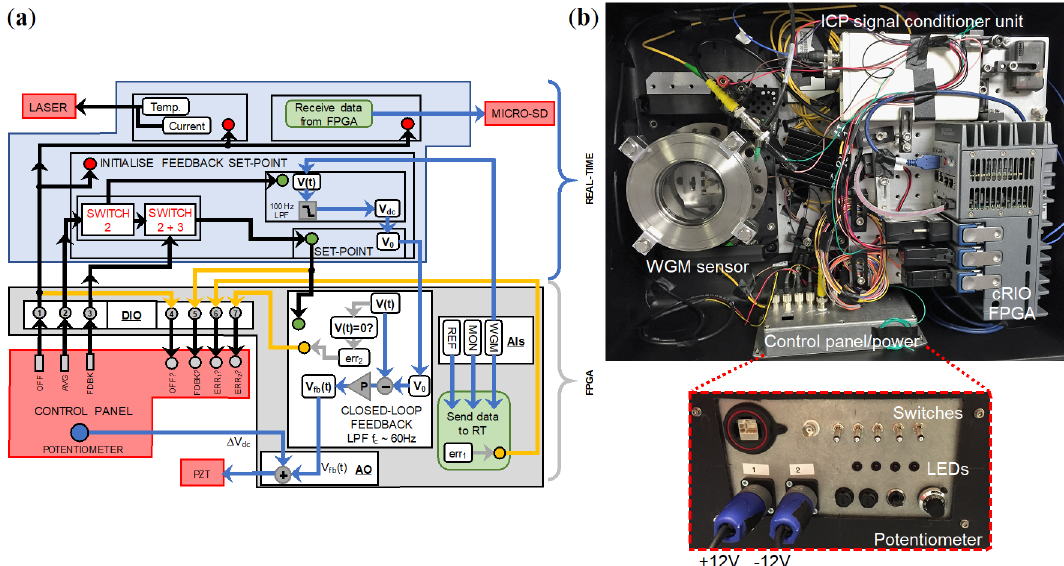
Figure 6. ( a ) Schematic of the automation protocol with tasks divided between the cRIO RT operating system and the embedded FPGA. ( b ) Complete prototype (portable batteries not shown) with inset photo of the outside-facing control